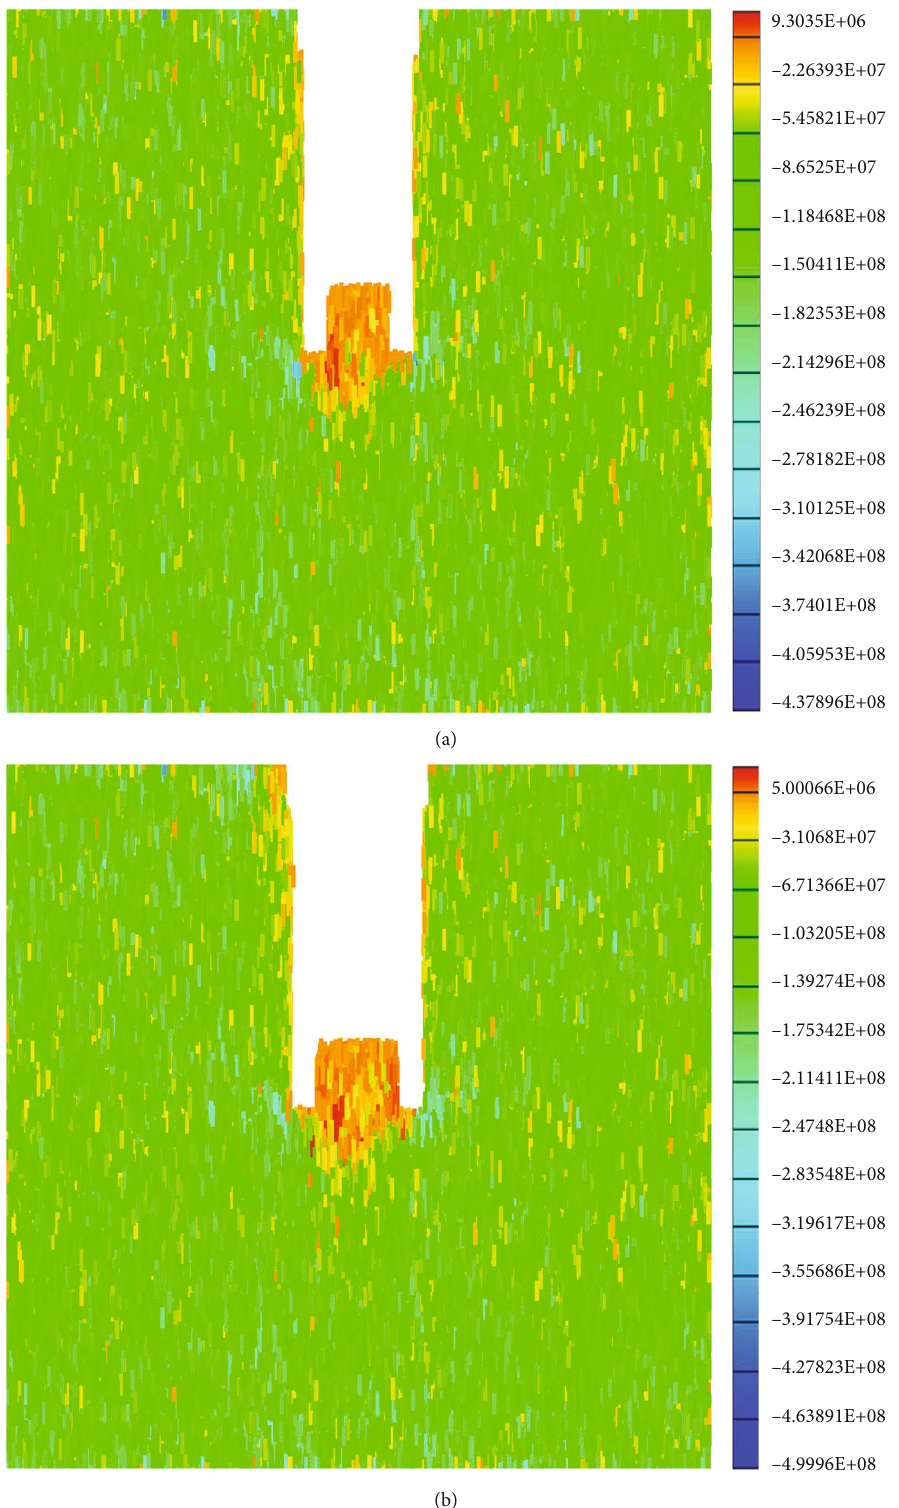
Figure 8: Typical stress cloud pictures of the model under di ff erent core diameters. (a) D = 9 : 00 mm . (b) D = 12 : 00 mm